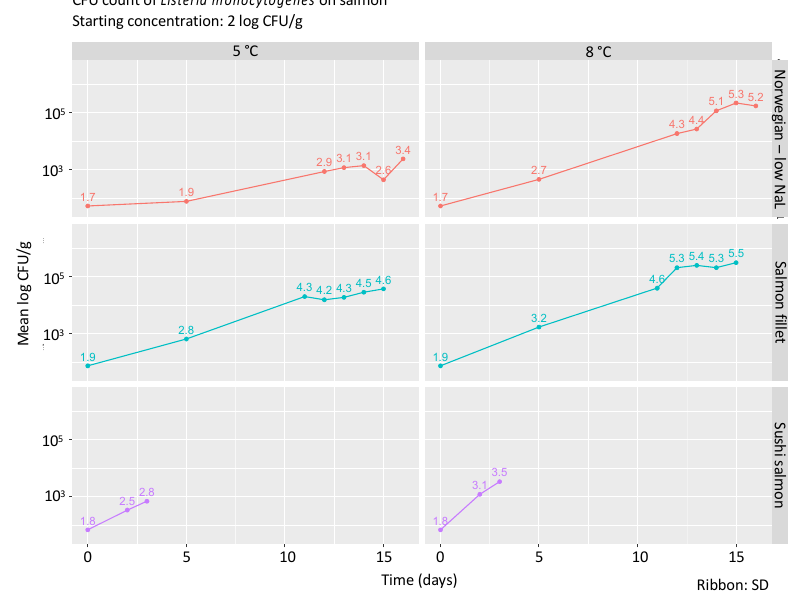
Figure 1. Growth curves of L. monocytogenes . The numbers above the time points reflect the mean log CFU/g from three replicates. The shaded area around the line represents the standard deviation. Due to the short shelf life of the sushi salmon, growth of L. monocytogenes was only investigated between t = 0 and t = 3 days. Over this period, the number of L. monocytogenes increased by 1.0 log CFU/g at 5 °C and 1.7 log CFU/g at 8 °C, respectively. The slope of the growth curves of L. monocytogenes in sushi salmon (0.33 at 5 °C, 0.57 at 8 °C) were steeper than those in Norwegian smoked salmon (low NaL) (0.05 at 5 °C/0.28 at 8 °C) and salmon fillets (0.29 at 5 °C/0.41 at 8 °C), indicating that sushi salmon offers the most favorable conditions for growth of L. monocytogenes in this setup (Figure 1, p -values for the difference between the slope of the growth curve of sushi salmon compared to that of Norwegian smoked salmon and salmon fillets: p = 0.084 at 5 °C, p = 0.048 at 8 °C). In Norwegian smoked salmon injected with low-NaL brine, growth of L. monocytogenes was observed between t = 0 and t = 16. During this time, L. monocytogenes increased by 1.7 log CFU/g at 5 °C and 3.5 log CFU/g at 8 °C, respectively. At 5 °C, a marked decrease in L. monocytogenes numbers